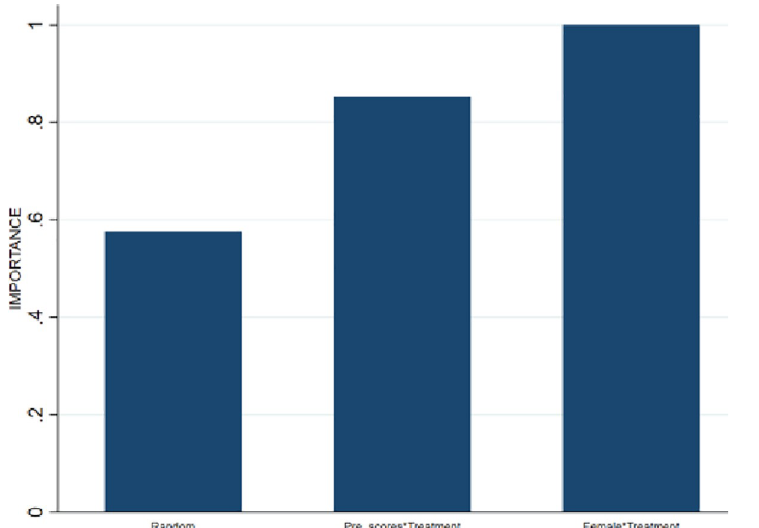
Fig 5. Importance graph simulated attrition interaction